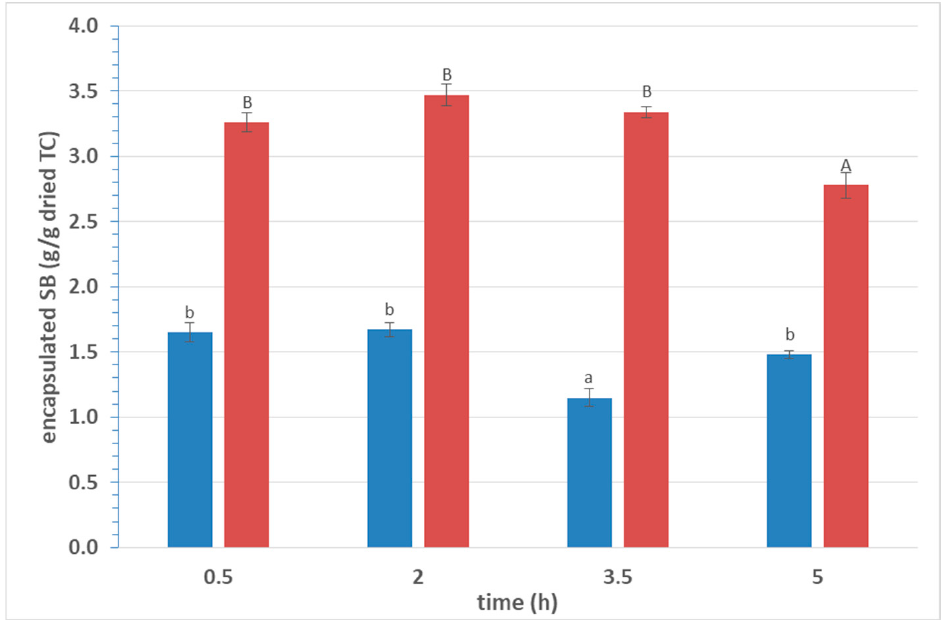
Figure 1. Effect of contact time on encapsulation of SB in dried TC. (SB: sodium benzoate; TC: tubular cellulose; ( ) 15% w/v SB; ( ) 30% w/v SB; means within the same SB concentration with different superscripts differ significantly ( p < 0.05)).